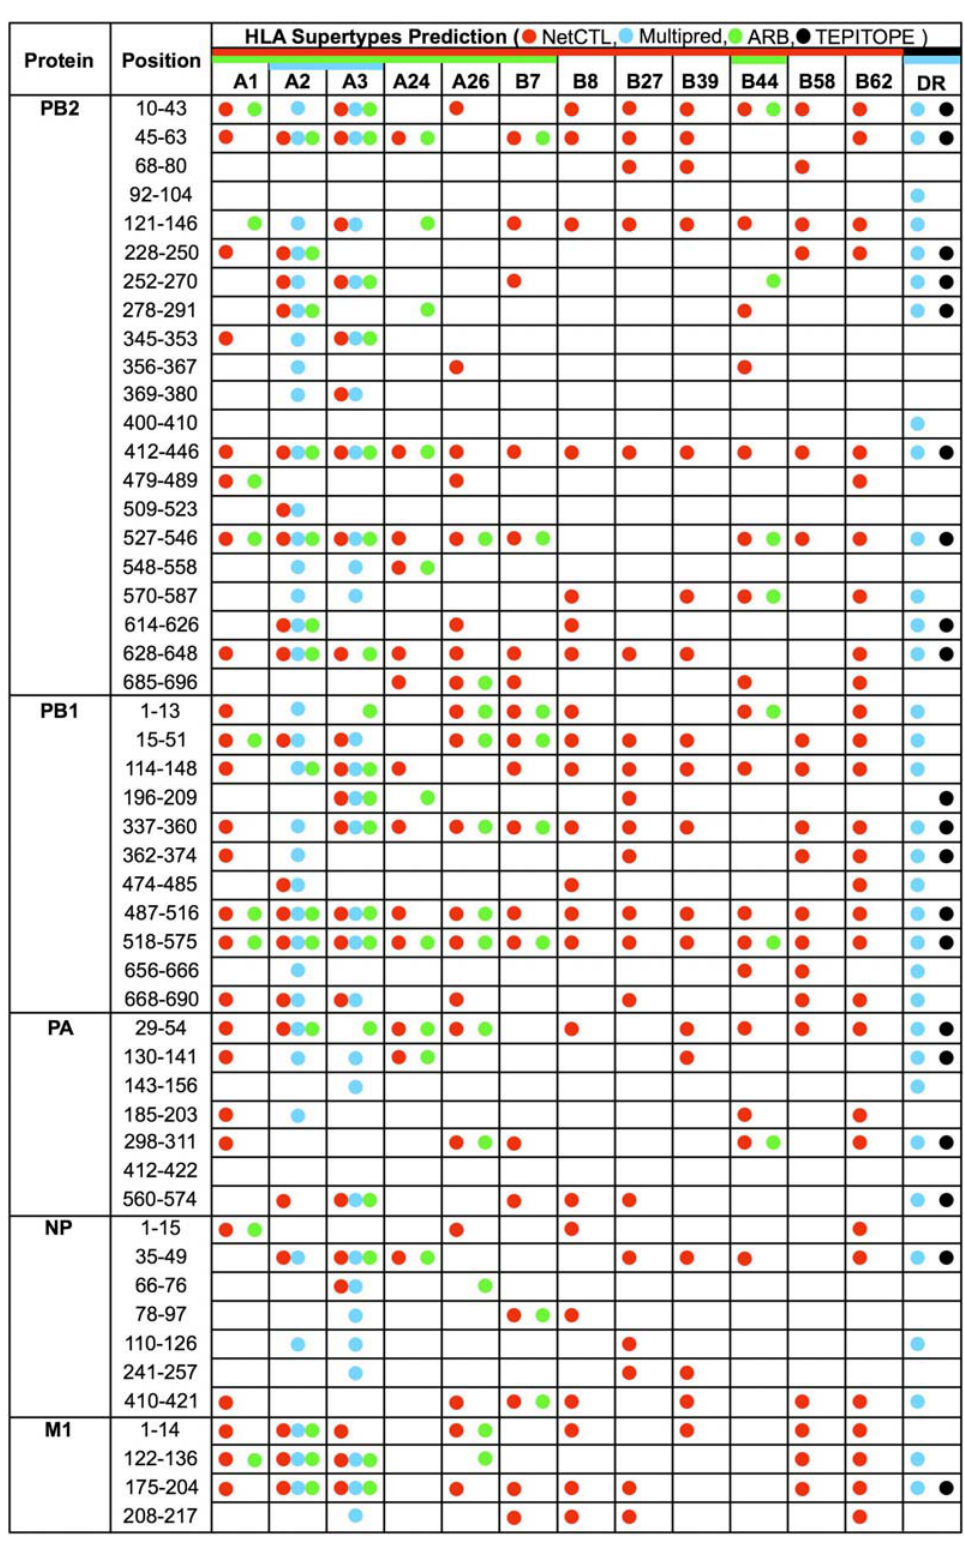
Figure 7. Highly conserved sequences of influenza A viruses and their predicted HLA class I and II supertype-restricted T-cell epitopes by NetCTL, ARB, TEPITOPE, and MULTIPRED systems. The color symbols corresponding to the prediction systems are as shown at the top of the figure. Only conserved sequences containing predicted alleles are shown. NetCTL predicts all of the listed class I supertypes; MULTIPRED predictions cover A2 and A3; and ARB predicts each of the class I except B8, B27, B39, B58, and B62. Predictions of HLA class II supertypes by MULTIPRED AND TEPITOPE is described in Materials and Methods.